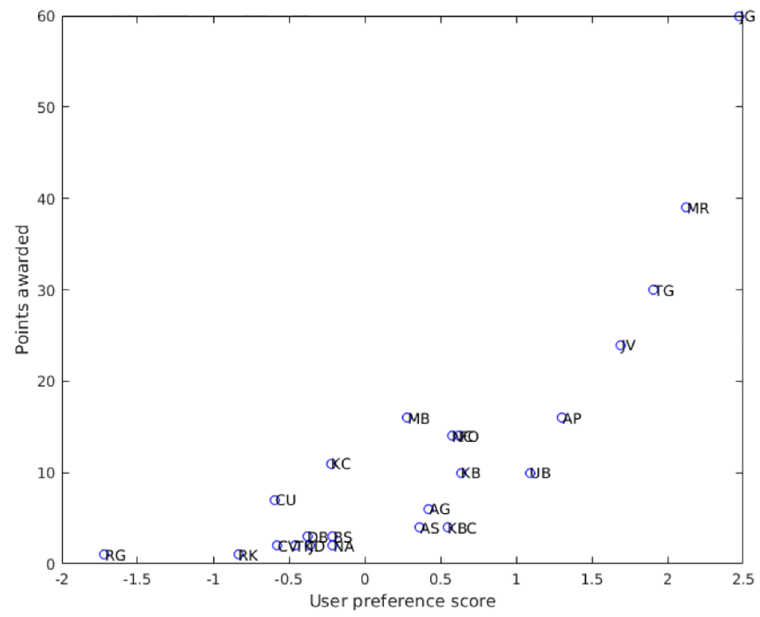
Fig 5. Scatter plot of the paired user preferencescores and points (calculated using the 2016 points system)awarded to the top 23 athletes.